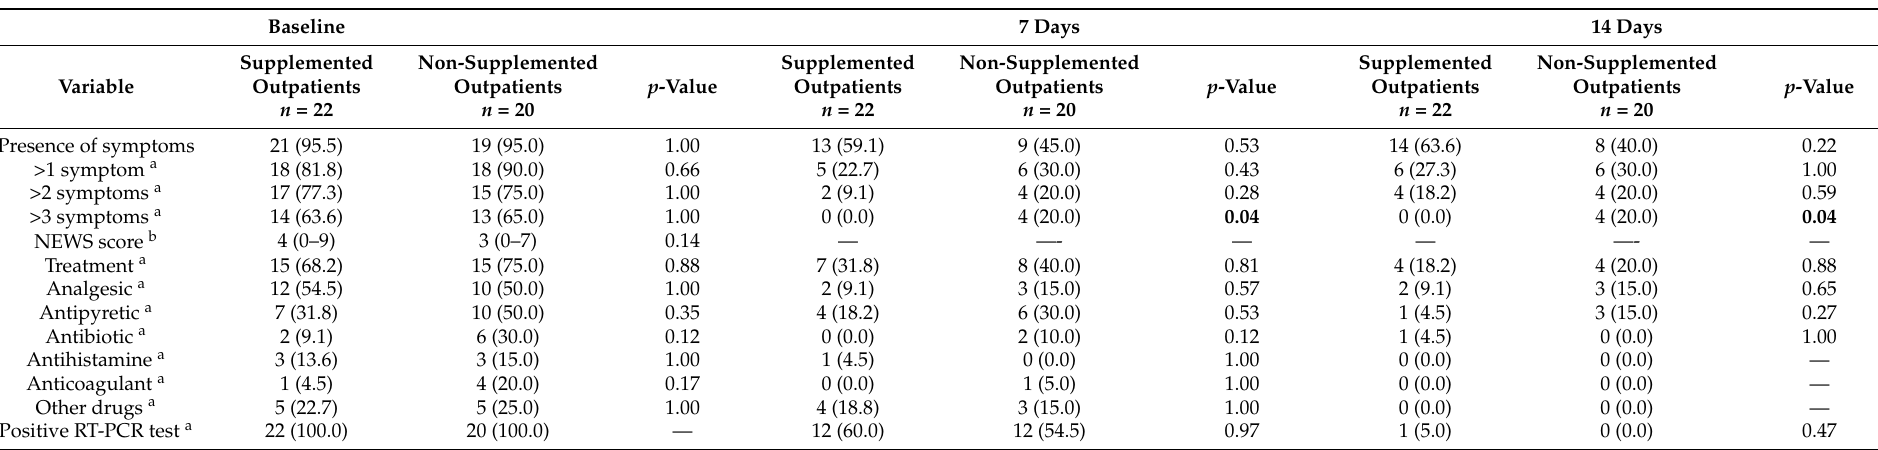
Table 3. Comparison of symptoms, treatment, and viral load in supplemented and non-supplemented outpatient study groups at baseline and follow-up at days 7 and 14.